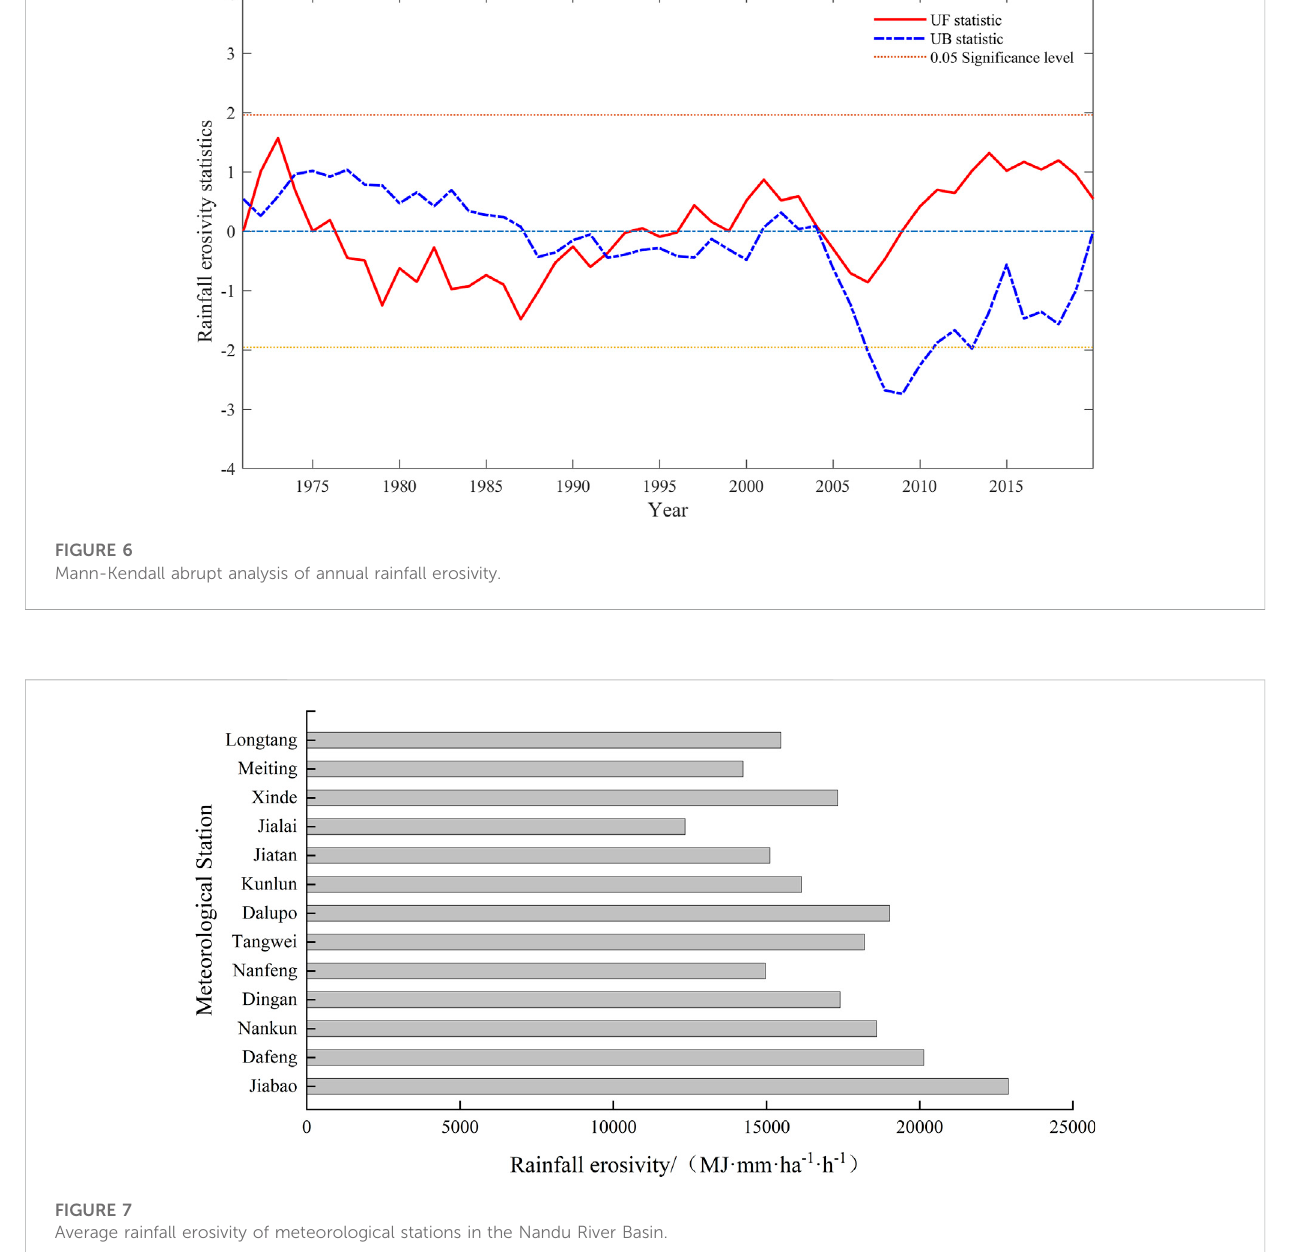
average erosive rainfall and rainfall erosivity (Figure 8). The maximum rainfall erosivity was distributed in the southeastern